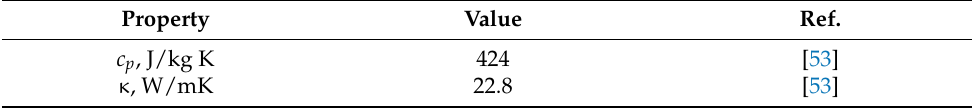
Table A19. Liquid -InP—thermophysical